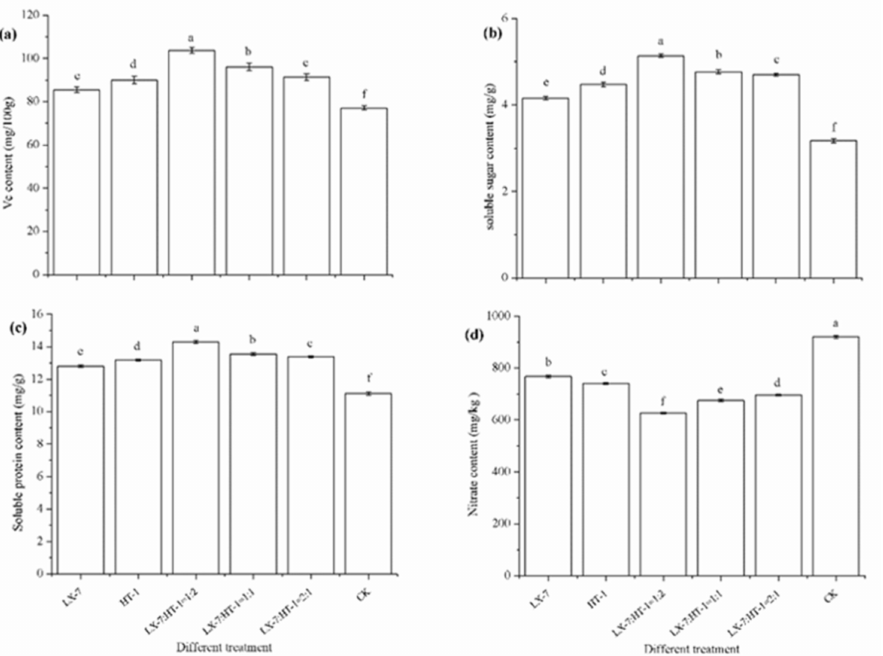
Figure 6. Effects of HT-1 and LX-7 strains on vitamin C ( a ), soluble sugar ( b ), soluble protein ( c ) and nitrate content ( d ) in Brassica chinensis L. plants under greenhouse. Values are mean ± SD (n = 15 plants). Different letters above the bars indicate the differences are significant at p < 0.05.